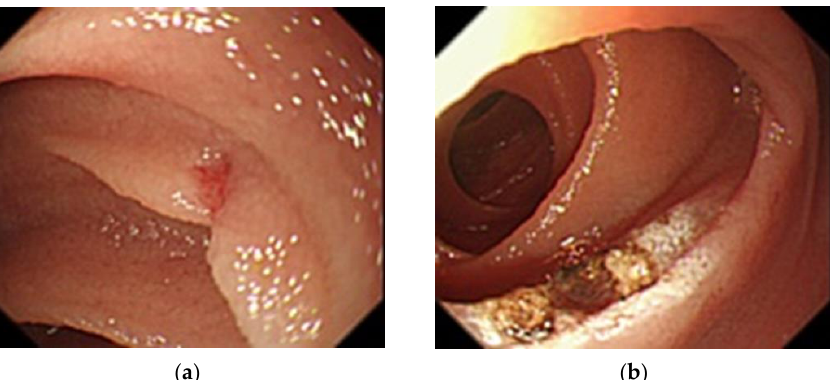
Figure 2. Balloon-assisted endoscopy findings at first examination. ( a ): A 2-mm angioectasia 120 cm distal to the ligament of Treitz in the small intestine with no bleeding source identified; ( b ): Argon plasma coagulation for the angioectasia.